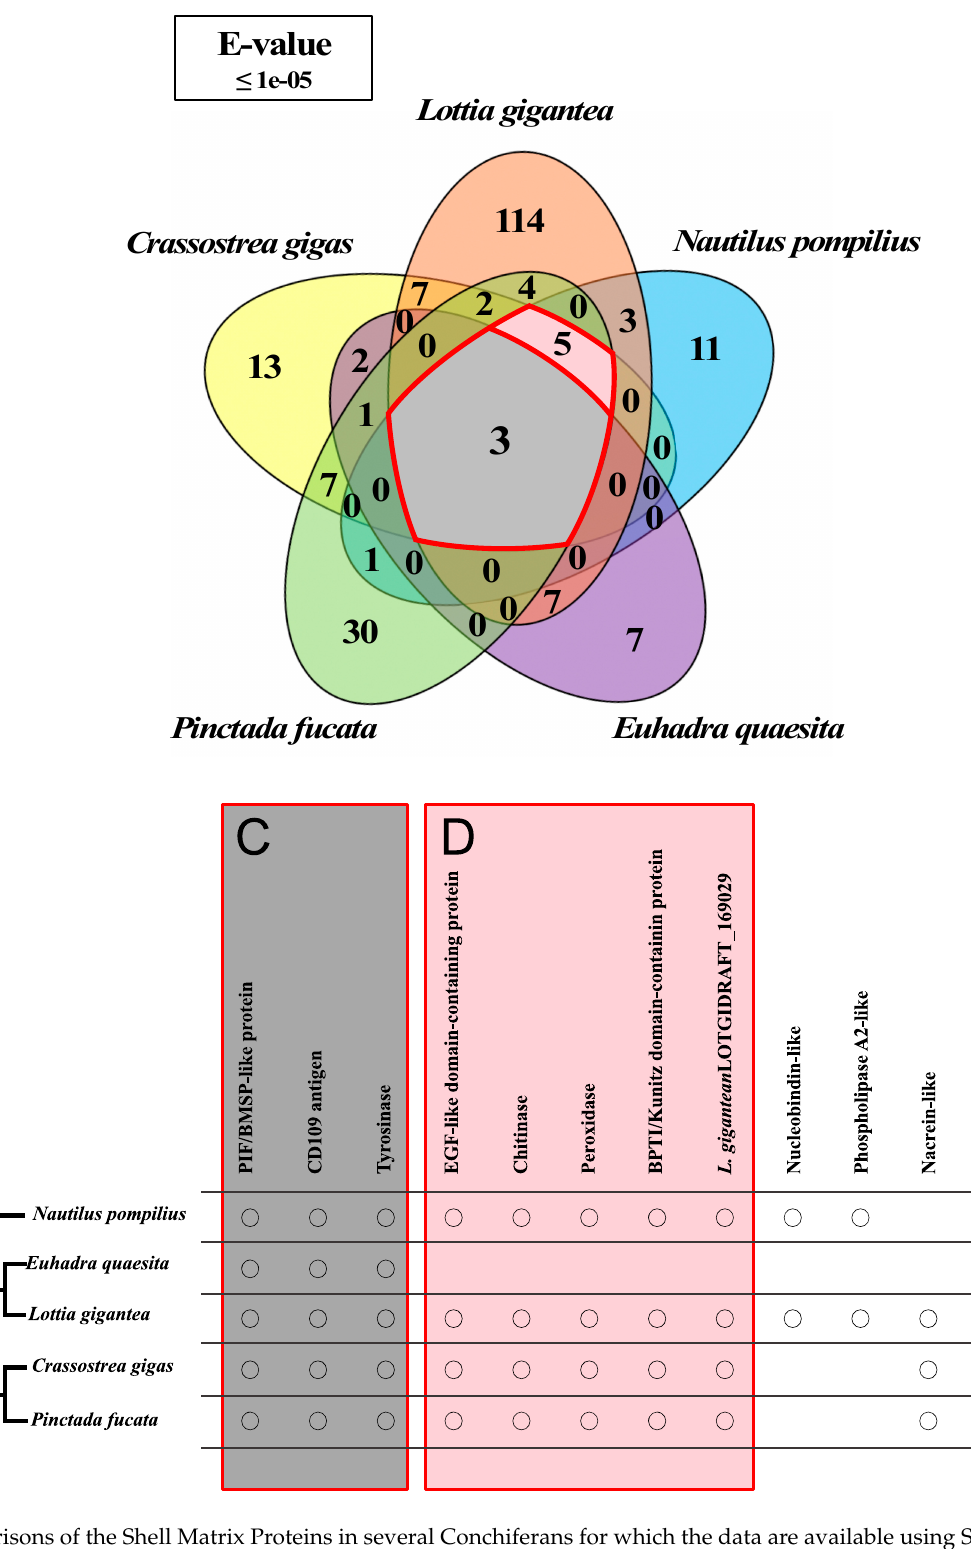
Figure 2. Comparisons of the Shell Matrix Proteins in several Conchiferans for which the data are available using Search Settings 2. Detailed explanation of the settings is written in the main text. ( A ) Venn diagram showing the numbers of shared proteins identified through local BLASTp searches among the five Conchiferans. Red line enclosure is the number of conserved proteins among the Conchifera. ( B ) Homologous proteins of the five Conchiferans compared, plotted on to the phylogeny of the animals. ( C ) Homologous proteins colored deep green were conserved among all five species. ( D ) Homologous proteins colored Pale green were conserved among marine mollusks.